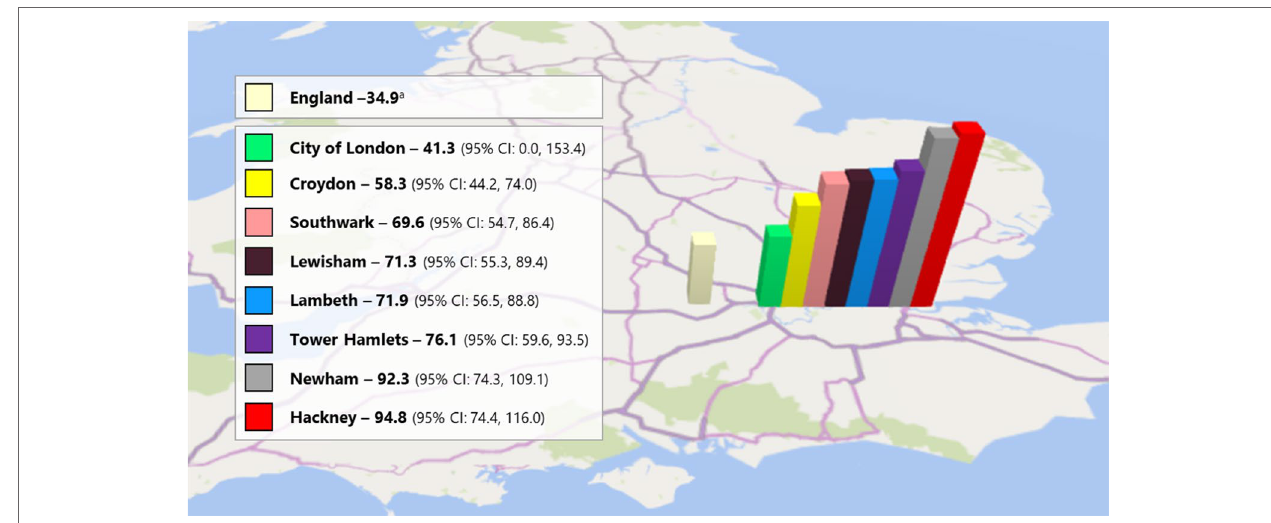
FIGURE 2 | Pan-London crude predicted incidence of psychosis per 100,000 person-year (16-35 years). a National average calculated from the PsyMaptic Psychosis LAD v1-0 xlsx file available at: http://www.psymaptic.org/prediction/psychosis-incidence-data/.